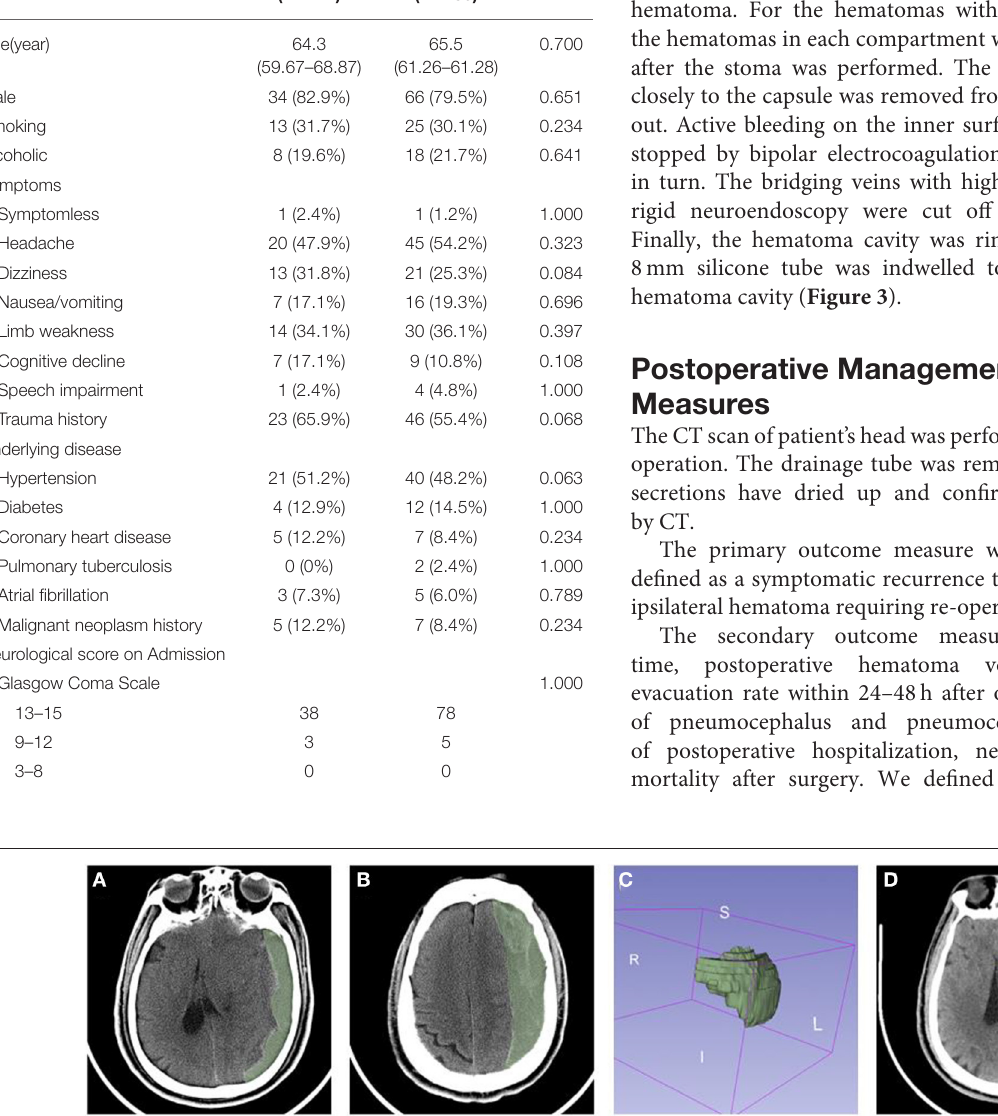
Frontiers in Surgery |